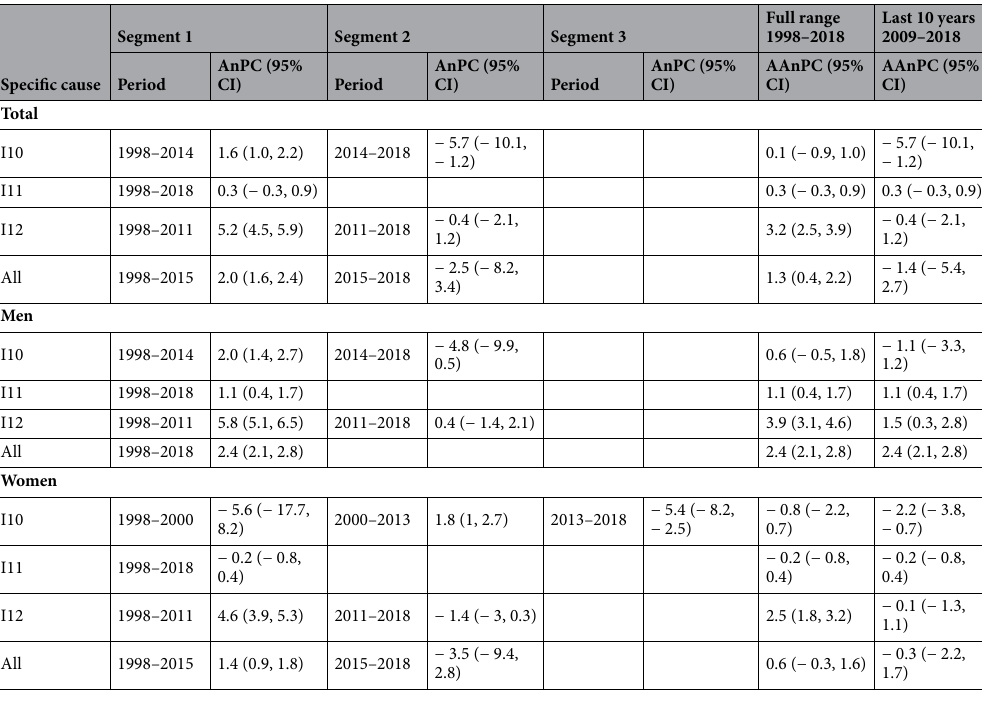
Table 1. Mortality (adjusted mortality rate by age) trends of hypertension by sex and specific cause (per 100,000 population), Mexico 1998–2018. AnPC annual percent change, AAnPC average annual percent change, I10 essential hypertension, I11 hypertensive heart disease, I12 hypertensive kidney disease, All all underlying causes due to hypertension (I10, I11, I12, I13 and